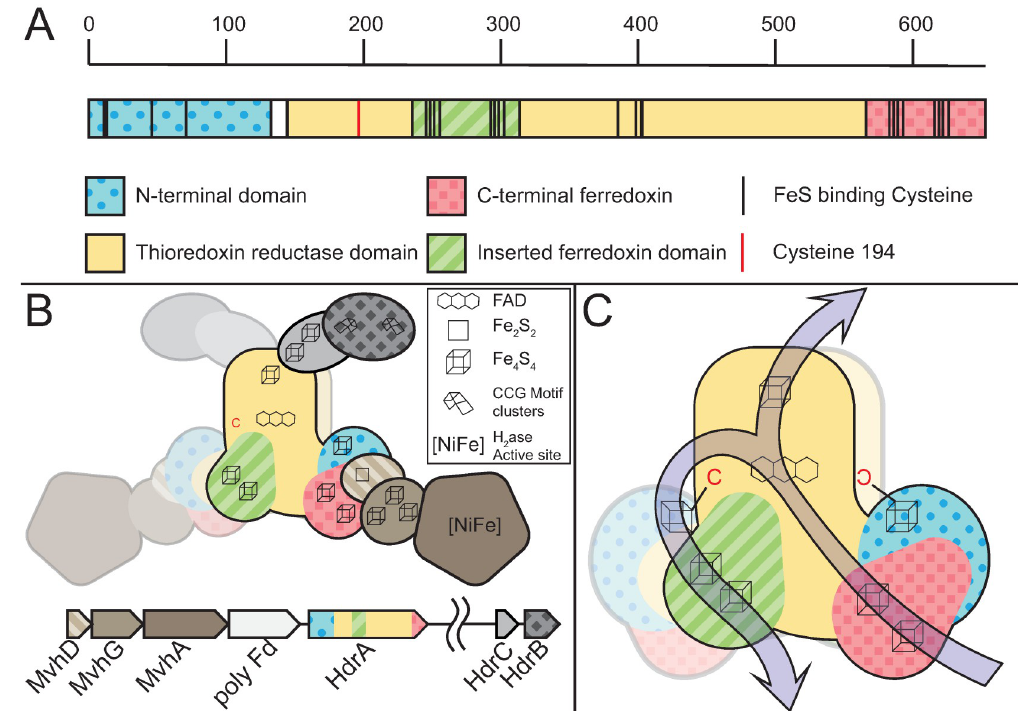
Fig 7. HdrABC structure overview. Depiction of the primary structure of HdrA and the quaternary structure of the HdrABC-MvhADG complex based on the structure from M . wolfeii . ( A ) HdrA can be broken down into 4 domains, the positions of these domains and key iron–sulfur cluster binding cysteines are illustrated, scale denotes amino acid position in the M . wolfeii sequence. ( B ) Quaternary structure of the entire HdrABC-MvhABG complex illustrating the dimeric structure. Metal cofactors involved in the oxidation/reduction of substrates or electron transport through the complex are highlighted. ( C ) Detail of HdrA domain structure highlighting cofactor position and proposed electron flow from MvhD in through the C- terminal ferredoxin, bifurcation through the FAD cofactor, with 2 electrons flowing out through HdrBC via the thioredoxin reductase domain’s FeS cluster, while 2 other electrons flow out through the inserted ferredoxin domain, presumably to free ferredoxin (Fd 2 − ). Importantly, for the proposed heterodimeric HdrA discussed here, this latter electron flow passes through the FeS cluster bound through a combination of Cys residues in the N-terminal domain, combined with a single Cys from the other HdrA subunit (Cys197 highlighted in red). FAD, flavin adenine